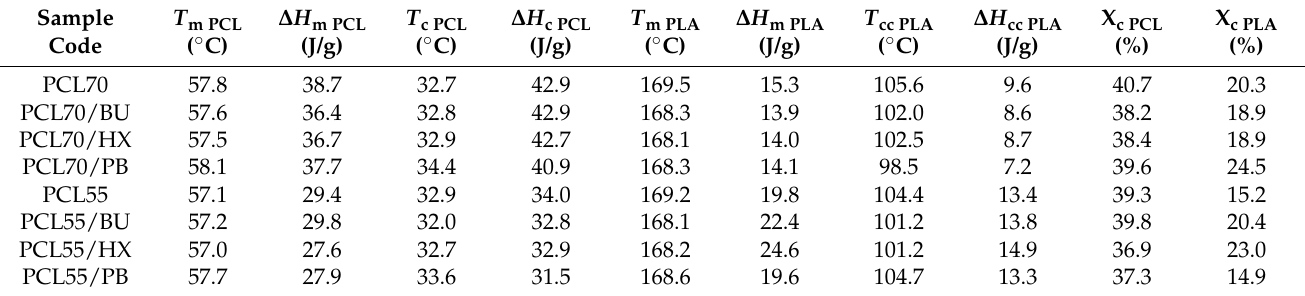
Table 3. DSC parameters (2nd heating) of PCL/PLA blends and PCL/PLA modified by OP.